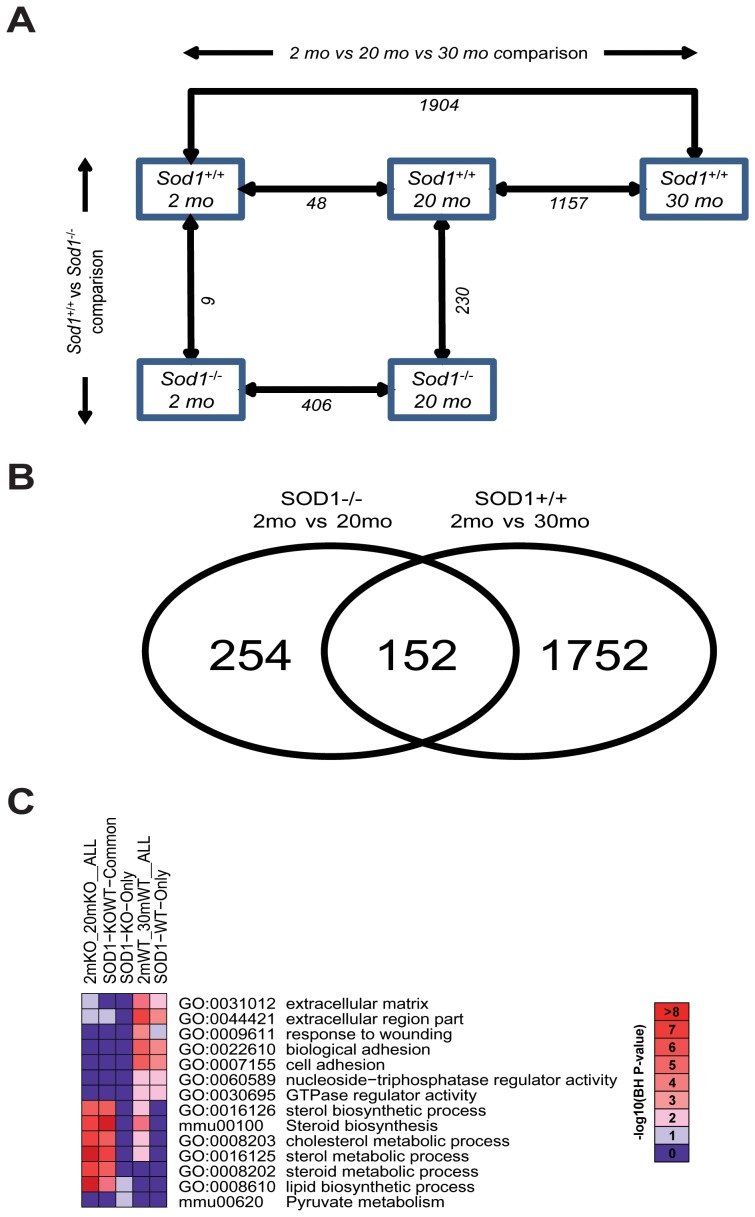
Assessment of gene expression in the sciatic nerve during aging.Alterations in the gene expression in the sciatic nerve during normal aging (Sod1+/+ mice at 2 mo and 30 mo) and during increased oxidative stress (Sod1−/− mice at 2 mo and 20 mo), were assessed using Affymetrix microarray technology. A) A comparison of the data sets for differential gene expression and the number of DEGs obtained in each comparison. IBMT FDR 5% was used to determine DEGs in age (horizontal) and genotype (vertical) group comparisons. The numbers of identified DEGs at each comparison are noted under the arrows. B) A Venn-diagram of the 2 mo/30 mo Sod1+/+ mouse comparison (normal aging) and the 2 mo/20 mo Sod1−/− mouse comparison (increased oxidative stress). C) The five DEG sets, including the two original DEG sets (denoted as 2mKO_20mKO__ALL (406 DEGs) and 2mWT_30mWT__ALL (1,904 DEGs)) and three subsets (common DEGs (denoted as SOD1-KOWT-Common (152 DEGs))) or unique DEGs to either set (SOD1-KO-Only (254 DEGs) or SOD1-WT-Only (1,752 DEGs)) from Figure 3B, were subject to functional enrichment analysis using DAVID. Benjamini-Horchberg (BH)-corrected P-values of the top 10 most significant functional terms are represented in a heat-map with –log10(BH-corrected P-value) as color index and number.